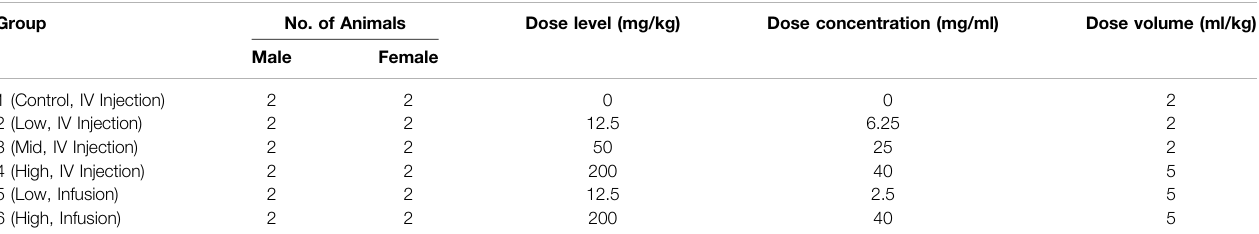
TABLE 2 | Dose range fi nding and TK study design by RPH-120 treatment. Group